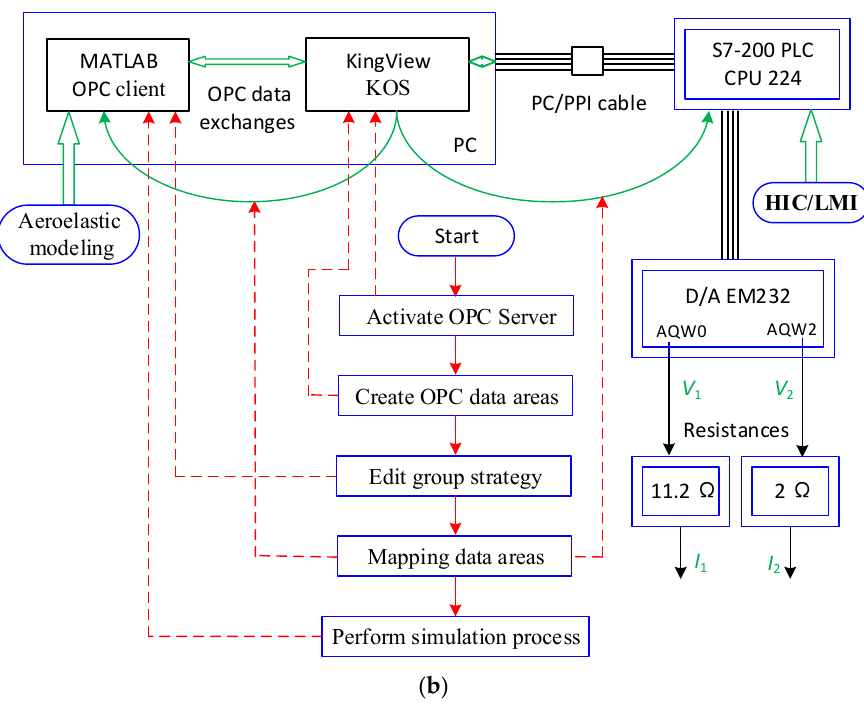
Figure 5. The experimental platform based on HTS: ( a ) view of configurations elements of experimental platform; ( b ) online real-time control based on Siemens S7-200 controller system and workflow of Kingview communication.